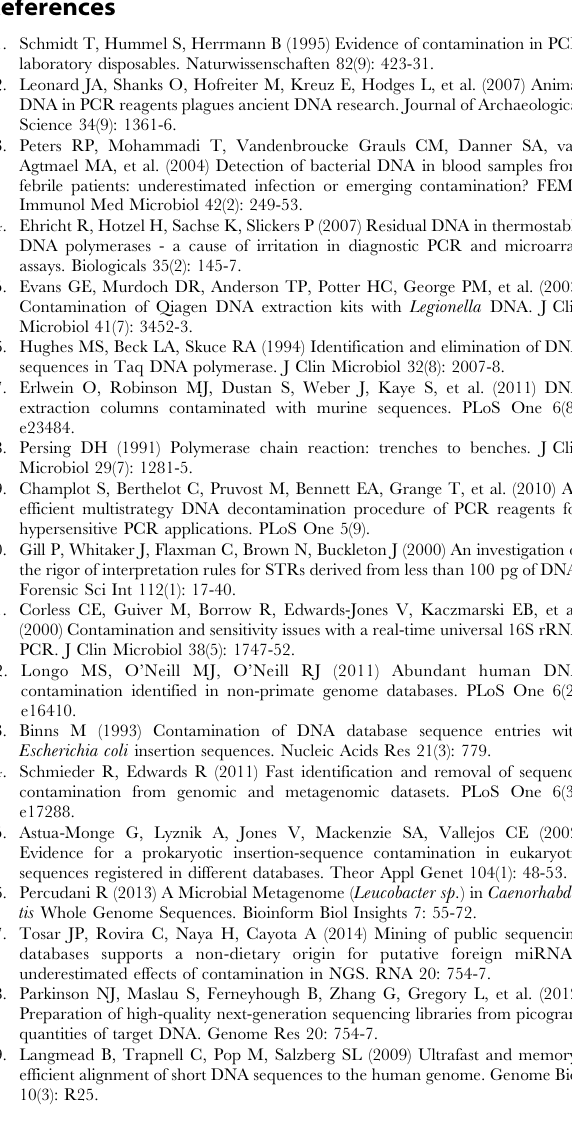
Table S3 The chloroplast genomes which made up the database used in Figure 4. Table S4 The total number of hits to each chloroplast genome in each library from the Tumor